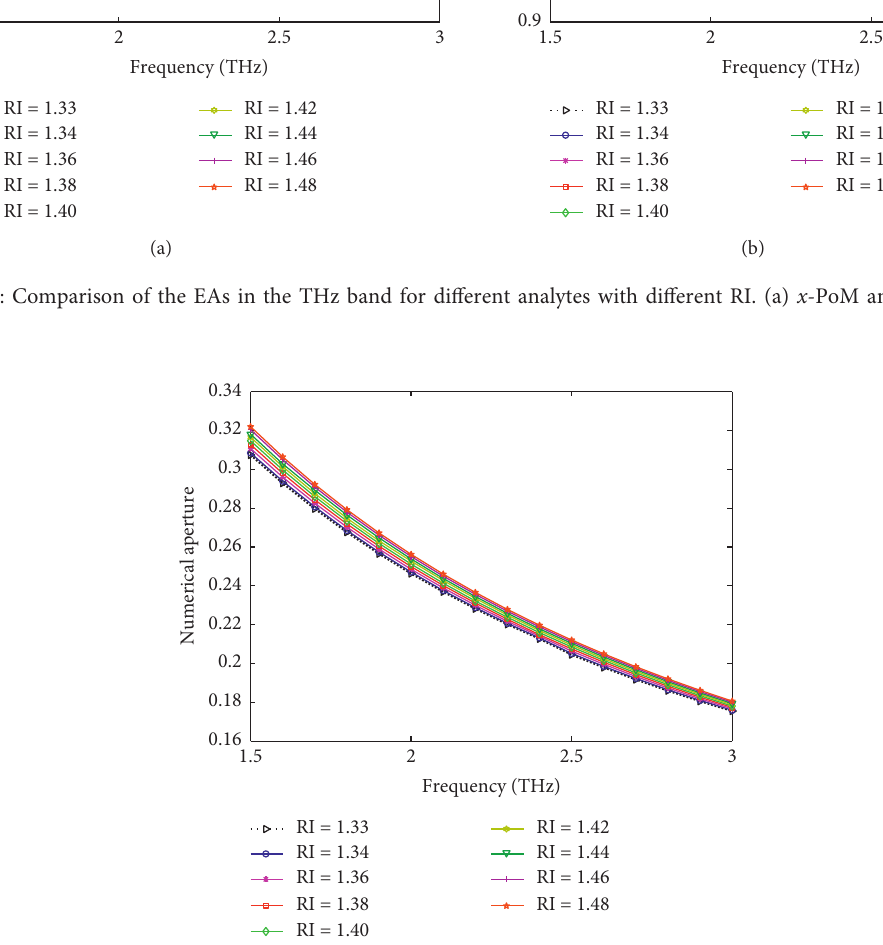
Figure 16: Representation of the numerical apertures in the THz band for different